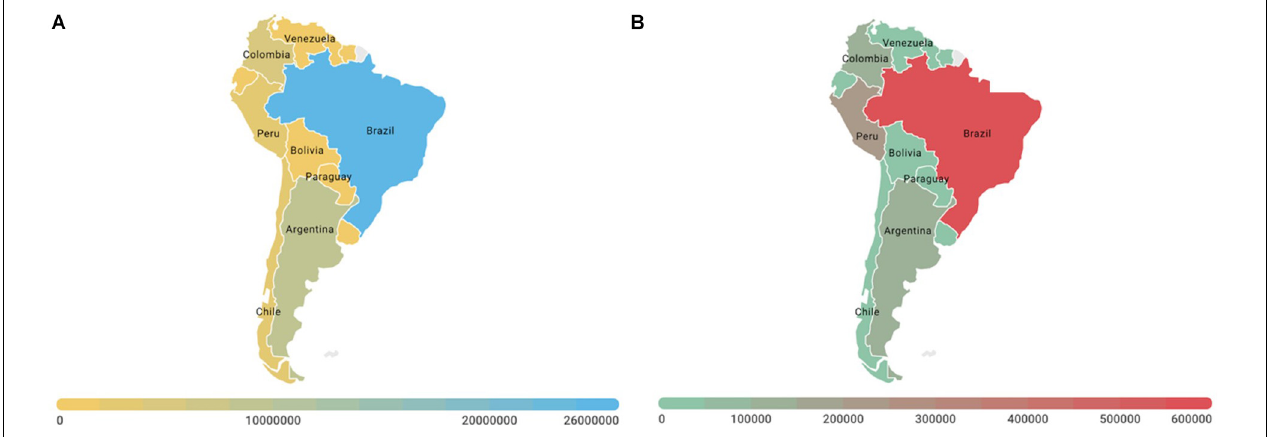
FIGURE 3 | Morbi-mortality associated with coronavirus disease (COVID-19) in Latin America. (A) Total confirmed cases and (B) total mortality in Latin American countries at February 3, 2022. Brazil is the Latin American country affected the most by the COVID-19 pandemic. As of February 2022, the country had reported over 26 million cases, and 630 thousand of deaths. Source WHO; CDC; ECDC; NHC; DXY.cn; Johns Hopkins University. TABLE 1 | Studies that assess the detection of Severe Acute Respiratory Syndrome Coronavirus 2 (SARS-CoV-2) in placenta around the world indicate the technique used and the state of symptoms. Method of detection of SARS-CoV-2 in placenta Presence of Total COVID-19 symptoms